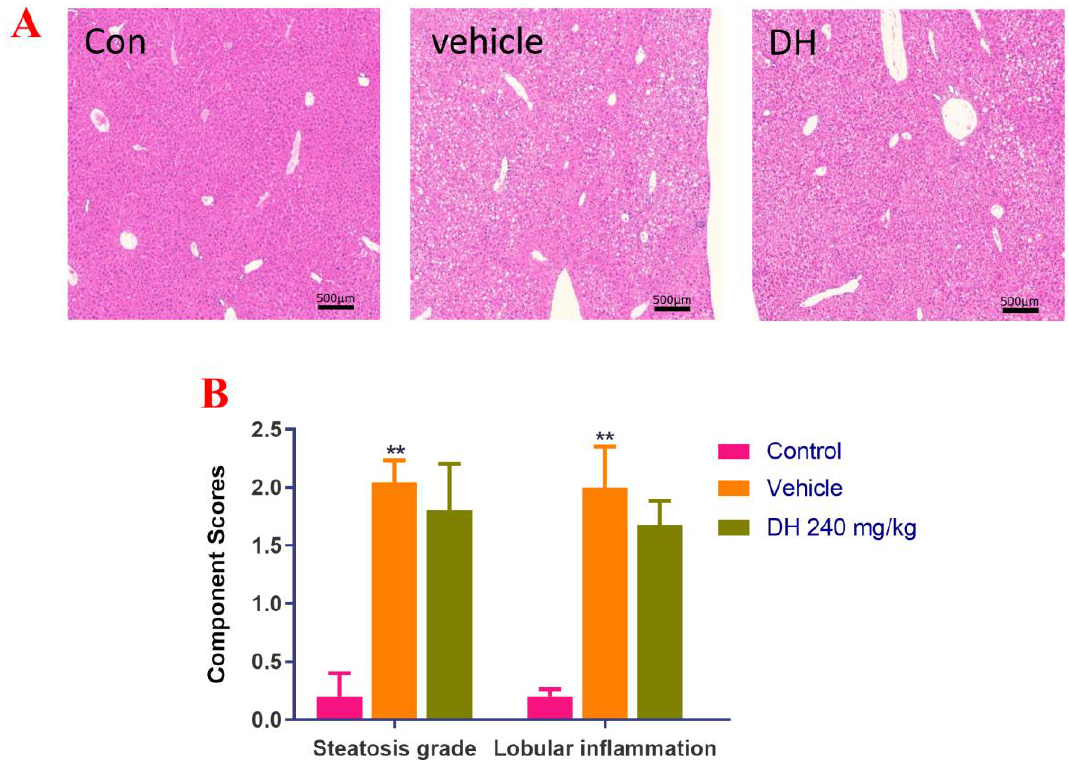
Figure 2. Investigation of steatosis in NASH mouse model after supplementation of mice with ethyl acetate extraction of D. heterophyllum extract supplementation of mice had no obvious effect on steatosis. We detected that steatosis is not obvious, but there is a certain tendency to alleviate lobular inflammation in the NASH mice. ( A ) HE staining results (500×), ( B ) NAS score. Con: control group; DH: 240 mg/kg ethyl acetate extract. Values are presented as the mean ± SD ( n = 10). ** p < 0.01 vs. the control group.